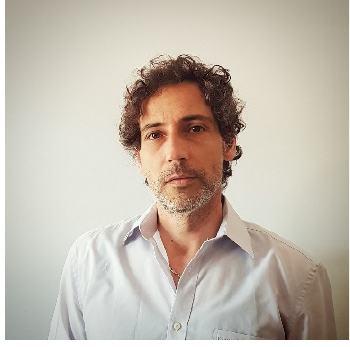
Figure 2. Giorgio Ercolano.